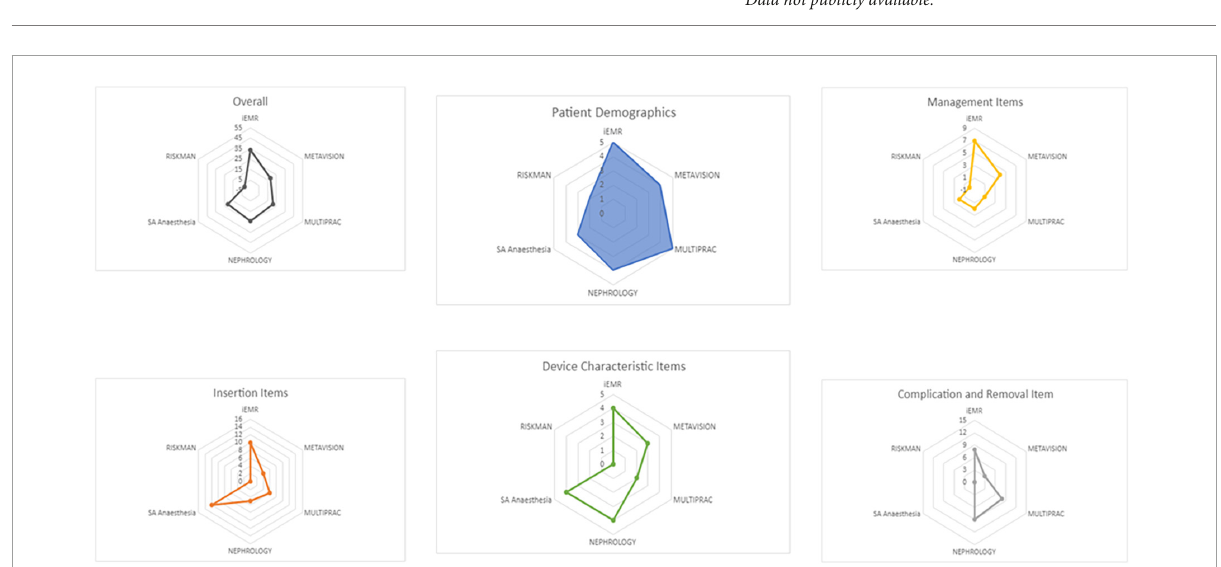
FIGURE2 Intravascular catheter data items collected in Queensland electronic data sources compared to international